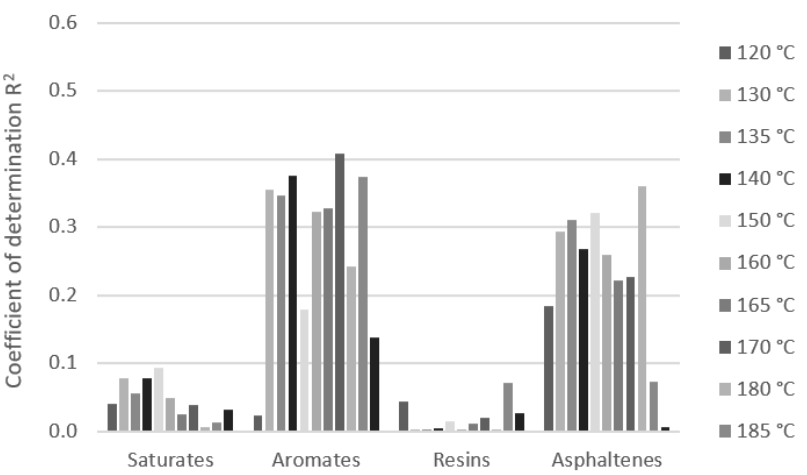
Figure 9. Coefficient of determination of linear model of dynamic viscosity and SARA composition at temperatures in the range 120 to 190 °C for group paving grade bitumen 50/70 samples.